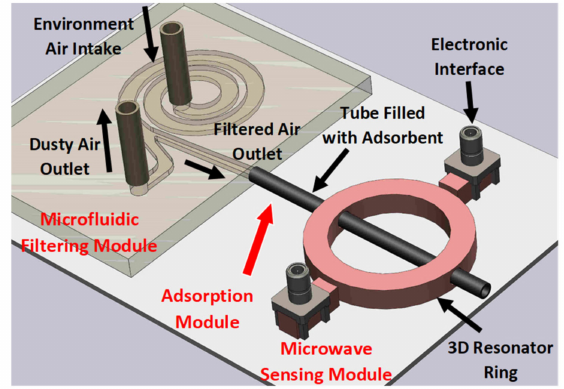
Figure 1. Schematic of the proposed modular gas sensor for in-line continuous gas detection in a particle-polluted